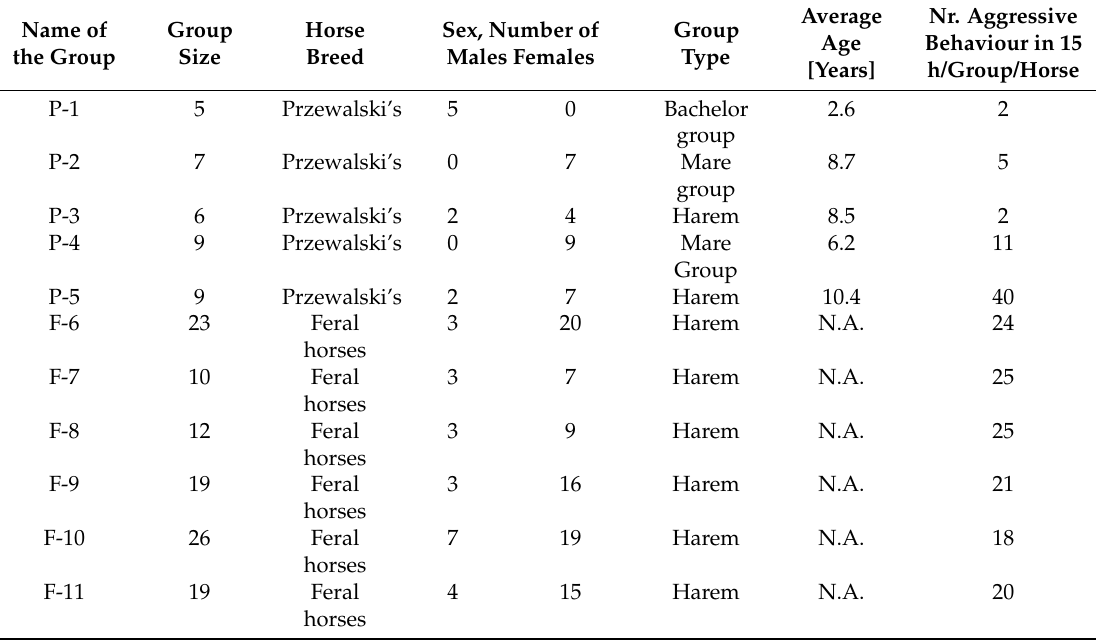
Table 1. Overview on the composition of the horse